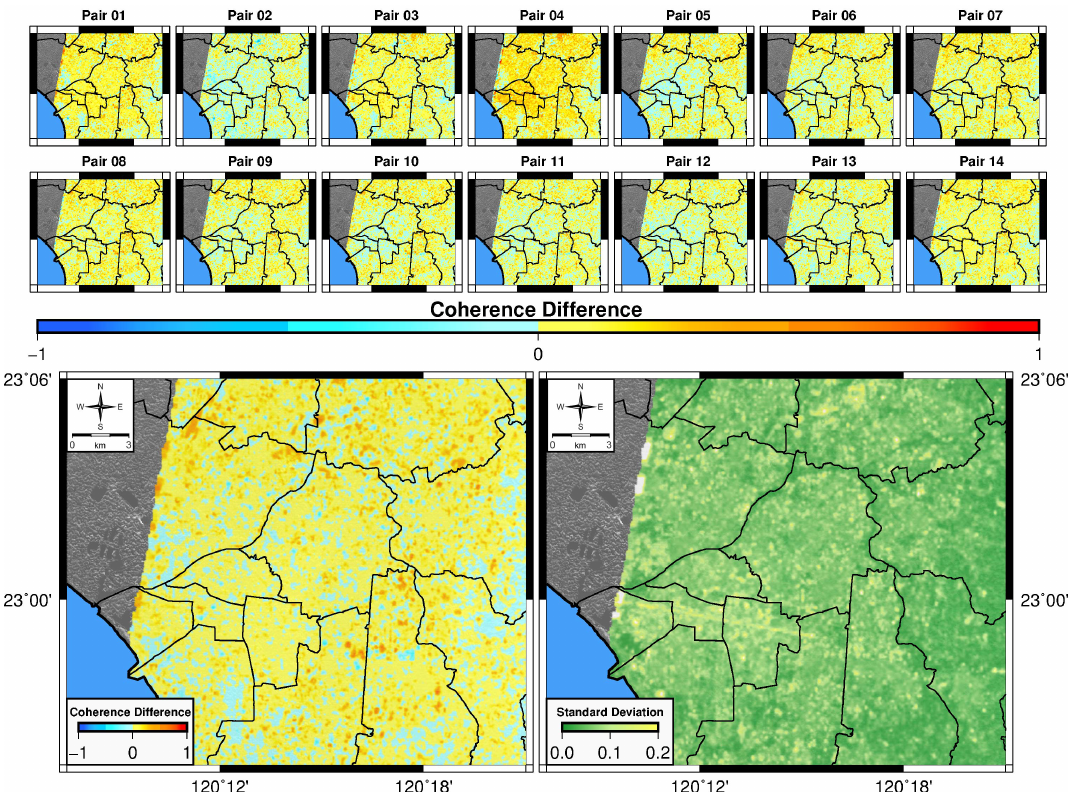
Figure 7. The background coherence difference results for descending orbits. The top two rows are the time series of coherence differences for the descending background image pairs. The subfigure in the lower-left quarter displays the mean values of coherence differences for descending background image pairs. The subfigure in the lower-right quarter shows the values of standard deviations for descending background image